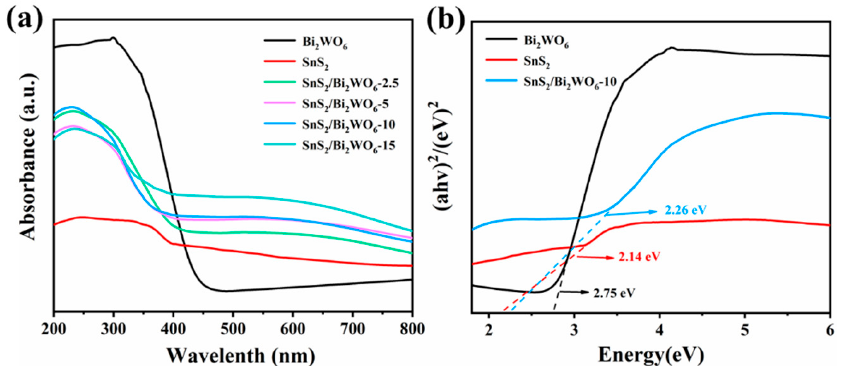
Figure 3. ( a ) Ultraviolet-visible diffuse reflectance spectra, ( b ) corresponding plots of ( α h ν ) 2 versus energy (h ν ) for the bandgap energies.